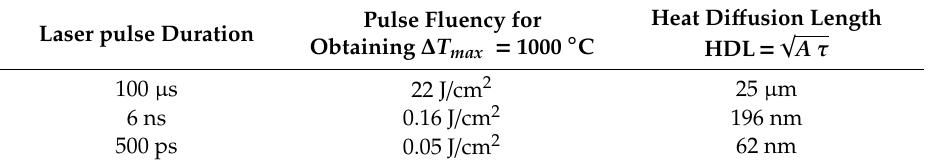
Table 3. Relation between laser pulse duration, fluency and heat di ff usion length